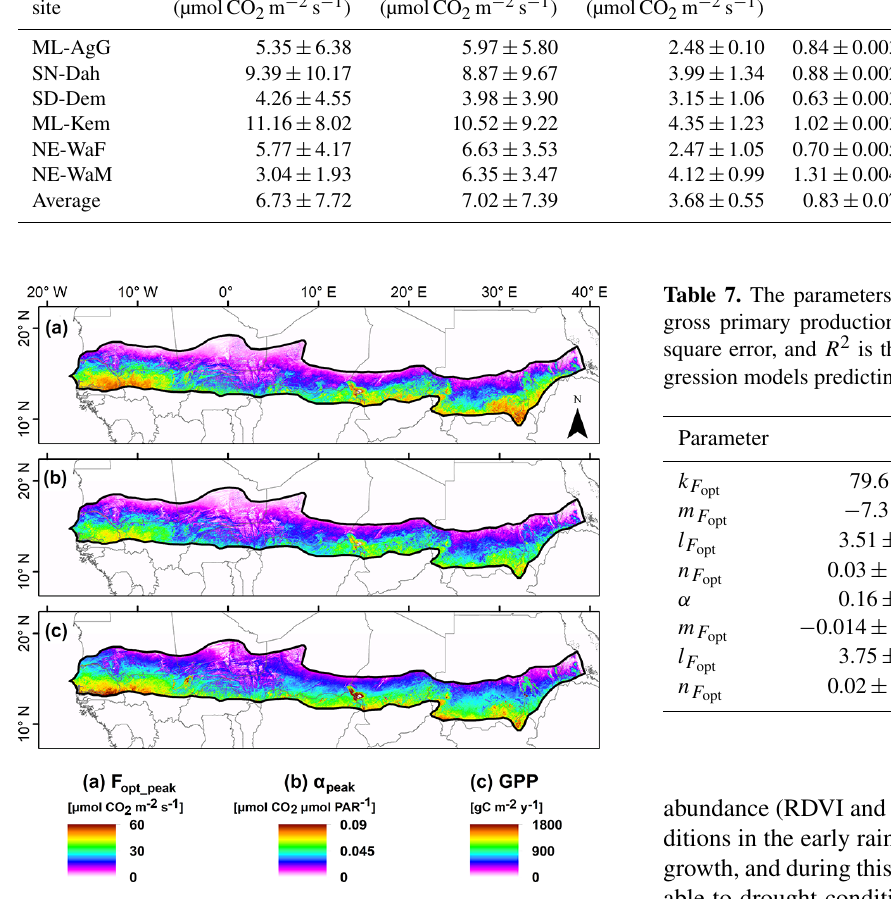
Figure 5. Maps of (a) peak values of photosynthetic capacity ( F opt_peak ) averaged for 2001–2014, (b) peak values of quantum efficiency ( α peak ) averaged for 2001–2014 and (c) annual budgets of GPP averaged for 2001–2014.